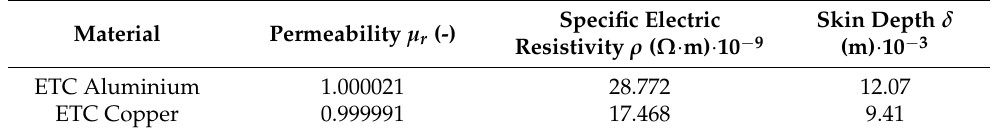
Table 1. Characteristic values for used metals.